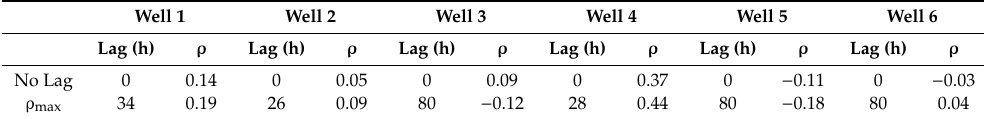
Figure 6. ( a ). Calculated Flux at 15 cm depth for all six multi-level samplers. ( b ). Precipitation and stage data. Stage is lowest in the summer (May–July) when flux rates are higher relative to fall, winter, and spring. Table 3. Spearman rank correlation coe ffi cients ( ρ ) for all six multi-level samplers at 15 cm midpoint depth. All ρ values were statistically significant for a 95% confidence level. The correlation coe ffi cient in the first row is between stage and flux with no forward time step. The second row indicates the maximum ρ values between stage and flux with incremental 2 h time steps in flux up to 80 h of lag time. There are positive and negative statistically significant weak correlations between stage and